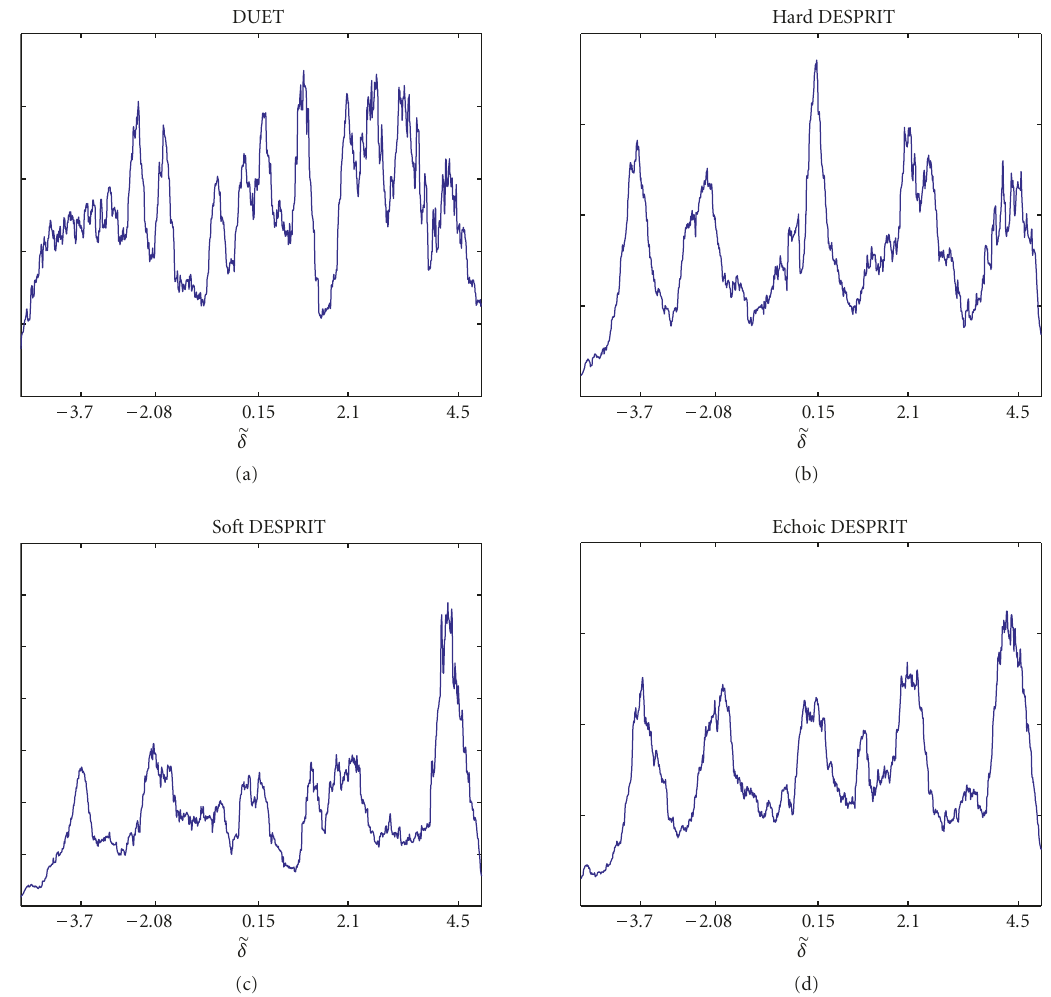
Figure 11: The histogram obtained by DUET algorithm when applied to 2 of the 4 real-room mixtures and the histograms obtained by the hard DESPRIT, soft DESPRIT, and echoic DESPRIT algorithms when they are applied to the 4 real-room mixtures.